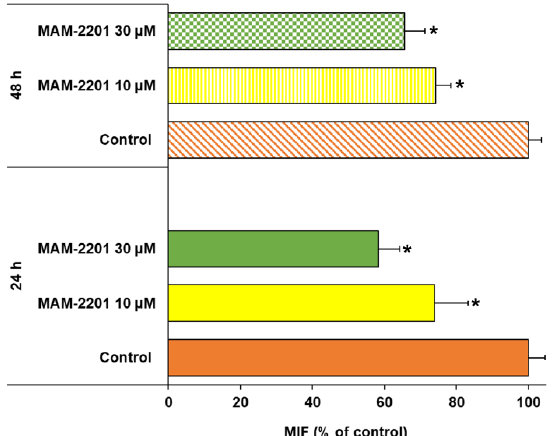
Figure 9. Flow cytometry analysis of cannabinoid receptor expression in D384 spheroids after 24 and 48 h of exposure to MAM-2201 (10 and 30 µM). Data are expressed as MFI percentages (% of respective control) and plotted as the means ± S.D. * p < 0.05, statistical analysis by one-way ANOVA followed by Tukey’s multiple comparisons test.